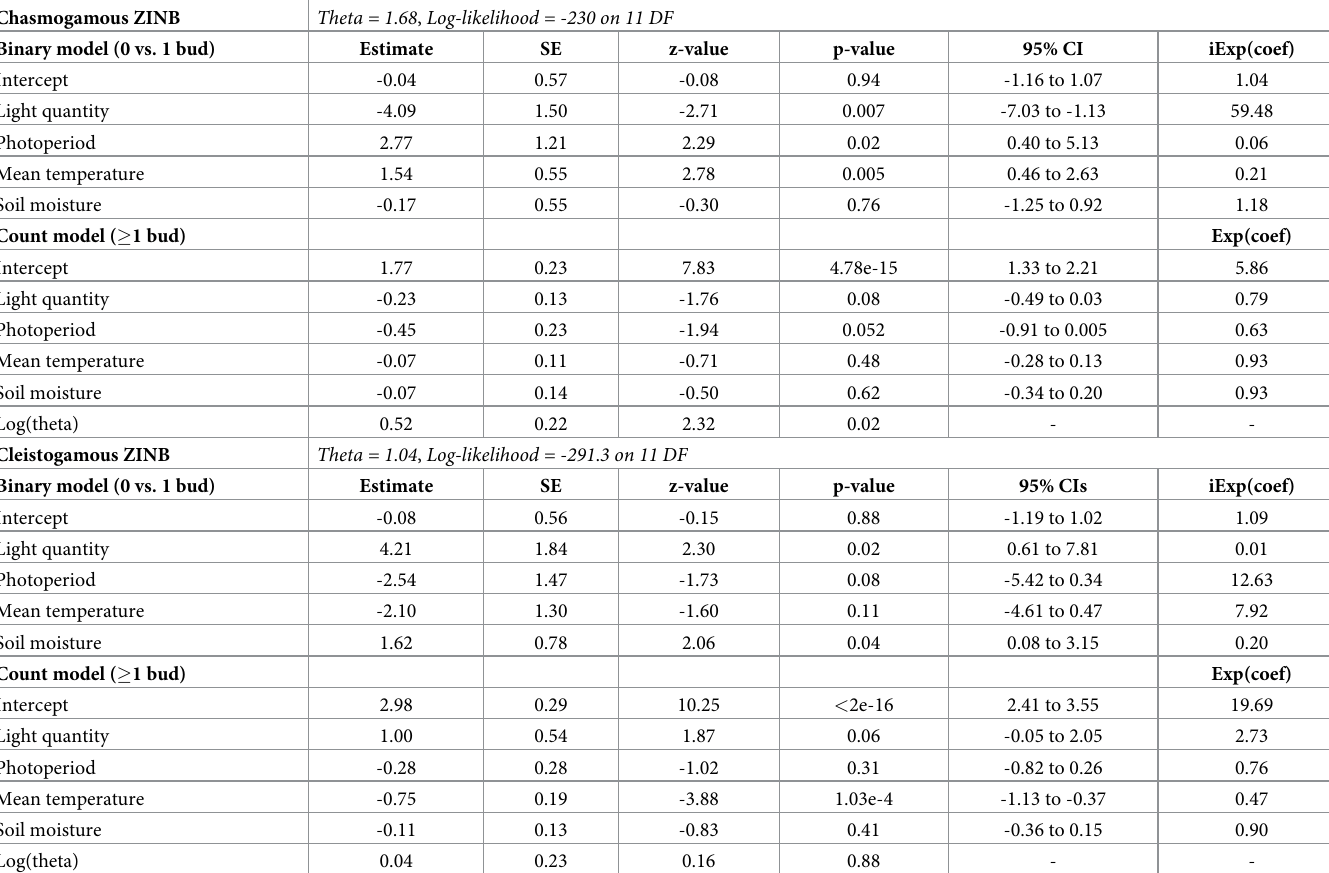
Table 2. Results of the zero-inflated negative binomial (ZINB) regression models predicting the odds of chasmogamous and cleistogamous buds developing and expected bud counts as a function of the averaged, z-score transformed environmental variables from 2016 and 2017. Chasmogamous ZINB Theta = 1 . 68 , Log-likelihood = -230 on 11